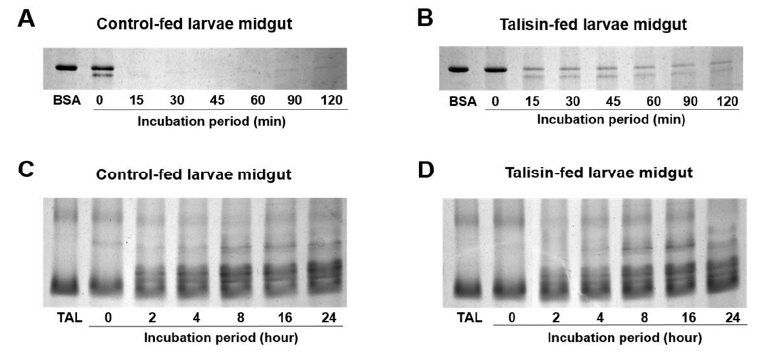
Figure 5. Resistance of talisin ( Talisia esculenta reserve protein) to hydrolysis by Spodoptera frugiperda midgut peptidases. SDS–PAGE of midgut juice extract mixed with talisin at a 1:5 (lectin to midgut homogenates) ratio and incubated at 30 °C for different periods. Digestion of BSA ( A ) and talisin ( C ) with midgut juice extract of control-fed larvae and digestion of BSA ( B ) and talisin ( D ) with midgut juice extract of talisin-fed larvae. TAL: talisin; BSA: bovine serum albumin; MG: midgut.